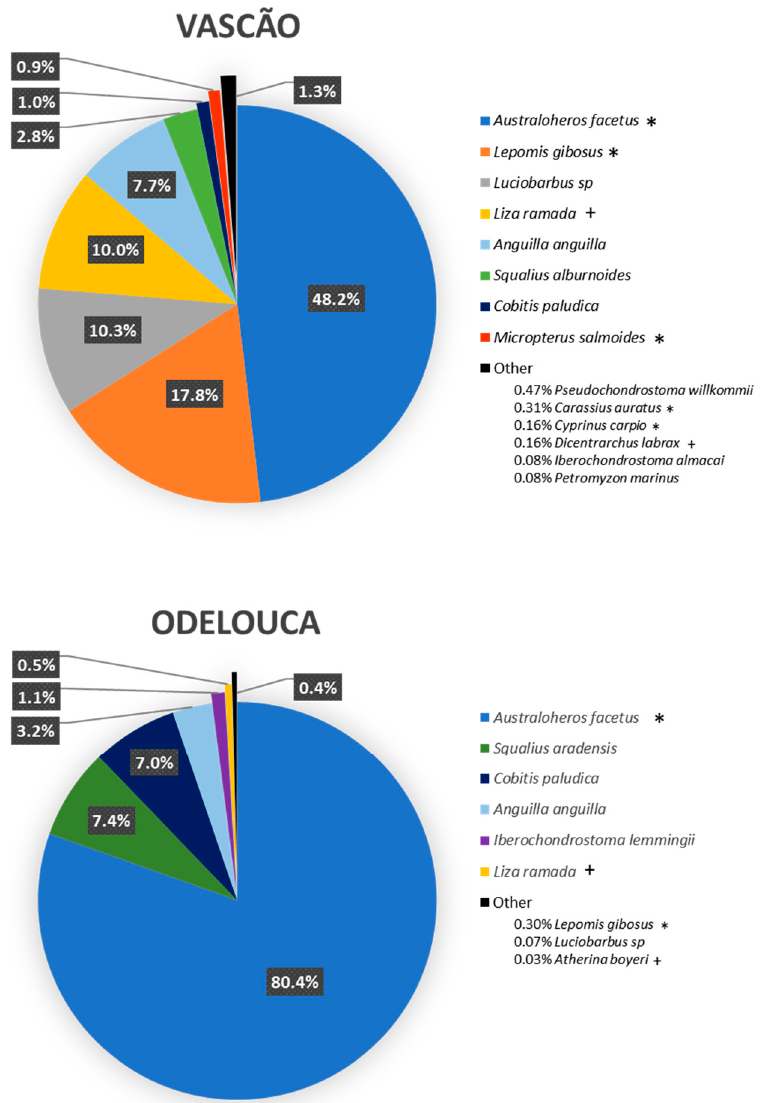
Figure 2. Relative abundance of fish species in the Vascão and Odelouca selected sites. Percentages were calculated using the sum of the individuals of each species recorded over the total number of individuals recorded in 4 years. Species with less than 0.5% of abundance were grouped as other. Asterisk (*) indicates non-native species and (+) indicates transient euryhaline species from marine origin.